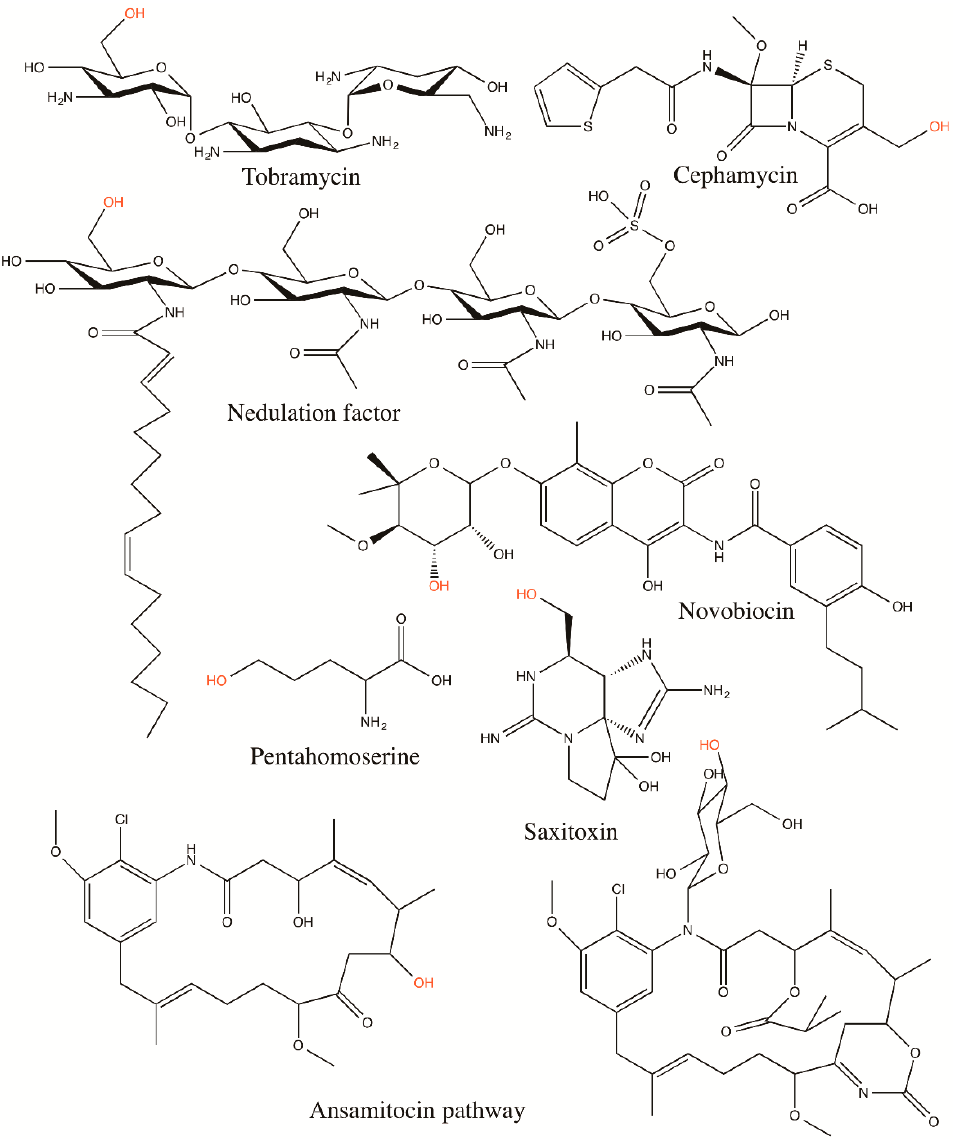
Figure 5. Schematic drawing of the structures of substrates of O -transcarbamylases. The oxygen hydroxyl group, labeled as red color, is the acceptor of the carbamyl group of CP during the transcarbamylation reaction catalyzed by O -transcarbamylases. In the ansamitocin biosynthetic pathway, carbamyl transfer reactions occur in two different positions, one on the backbone ring and